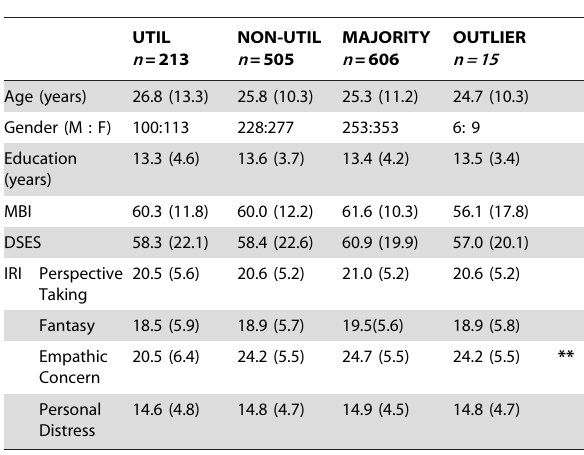
Table 1. Mean ( SD ) values for demographic variables and data obtained from Experiment 1 with questionnaires measuring moral knowledge, religiosity, and empathy.